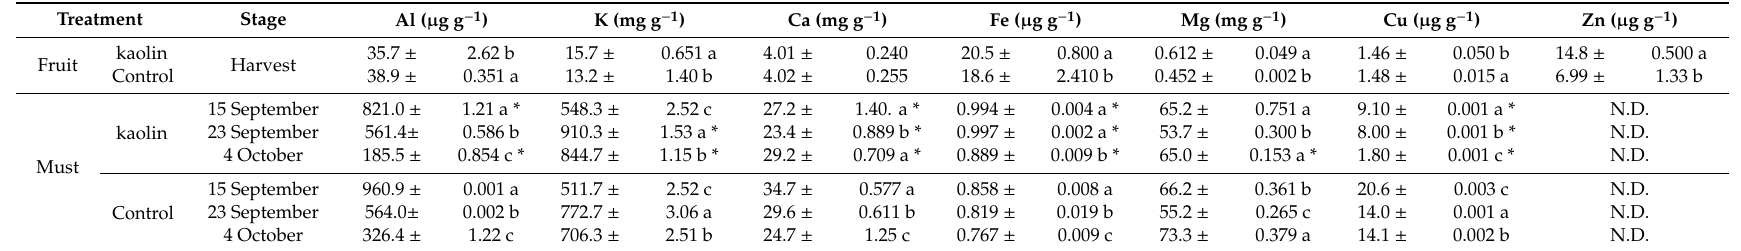
Table 6. Mineral composition of white grape berries and must in di ff erent stages of ‘Cerceal’ cv. from kaolin treated and untreated (control) plants. Values are presented as mean ± SD. Di ff erent lowercase letters represent significant di ff erences between treatments (control vs. kaolin), in the same stage of the season (veraison / maturation) and * represents significant di ff erences between stages of the season within the same treatment ( p < 0.05). Absence of superscript indicates no significant di ff erences. N.D. means that concentration was so low that it was not